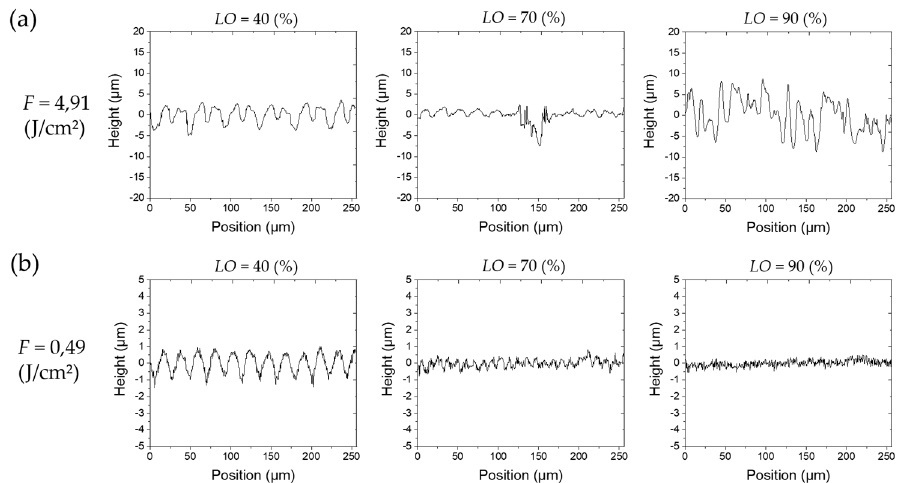
Figure 6. Exemplary height elevation profiles in x-direction at different LO (40%, 70% and 90%) and different fluences ( F = 4.91 J/cm² and F = 0.49 J/cm²). ( a ) Low levels of LO lead to considerable formation of trenches ( LO = 40%). Firstly, structures become smaller with increasing LO ( LO from 40% to 70%). After reaching the high ablation regime, stochastic microstructures gradually grow with increasing LO at high levels of F. ( b ) The periodicity and height of structures decreases with increasing LO . High LO leads to a clear homogenous nanoscale roughness.